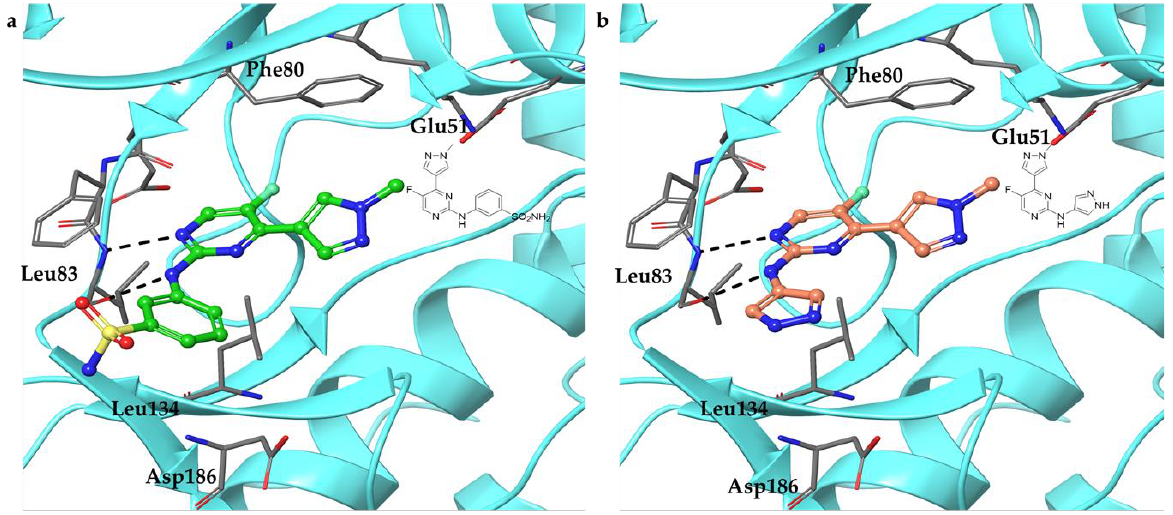
Figure 2. Predicted binding pose of 1 ( a ) or 14 ( b ) in CDK2/cyclin E (PDB ID: 7KJS). The kinase is presented in cyan ribbons with selected amino acids annotated, while 1 and 14 are colored green and salmon, respectively. Hydrogen bonds are indicated by dashed black lines. The illustration was generated using Maestro Schrödinger Release 2021-1.